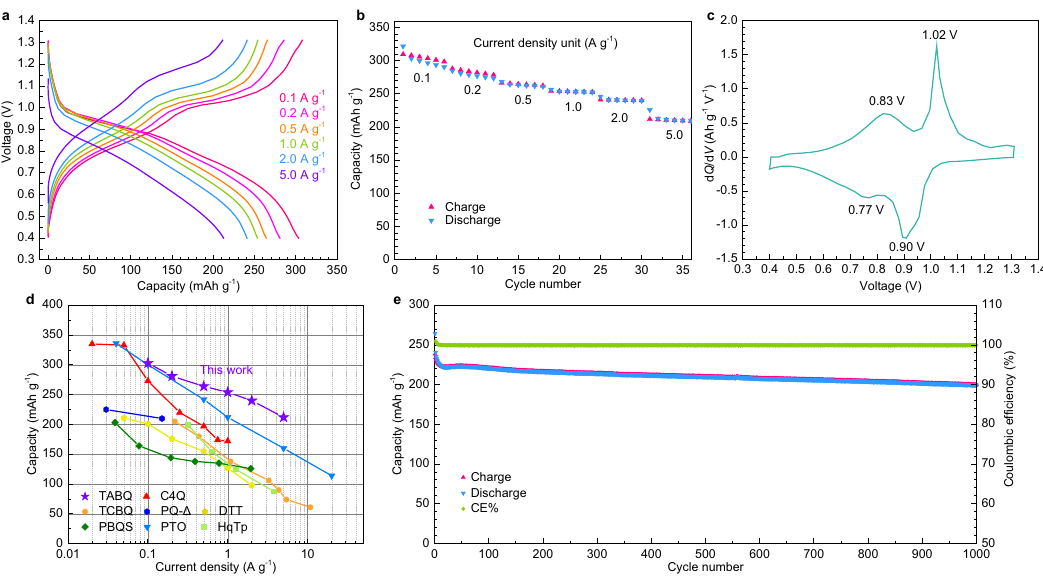
Fig. 2 Electrochemical performance of the TABQ cathode in aqueous zinc-organic batteries. a Charge/discharge curves and b capacity evolution under various current densities. c Differential capacity curve at 0.1 A g − 1 . d Comparison with previously reported quinone materials. e Capacity and coulombic ef fi ciency evolution at 5 A g − 1 for 1000 cycles.